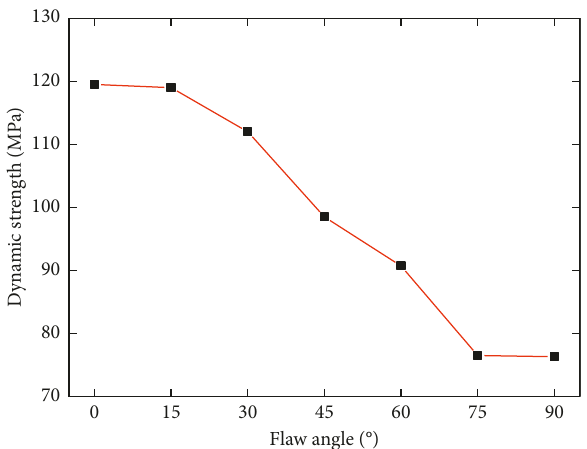
Figure 6: Influence of the flaw angle on the dynamic strength of specimens with a constant ligament angle of 0 ° .